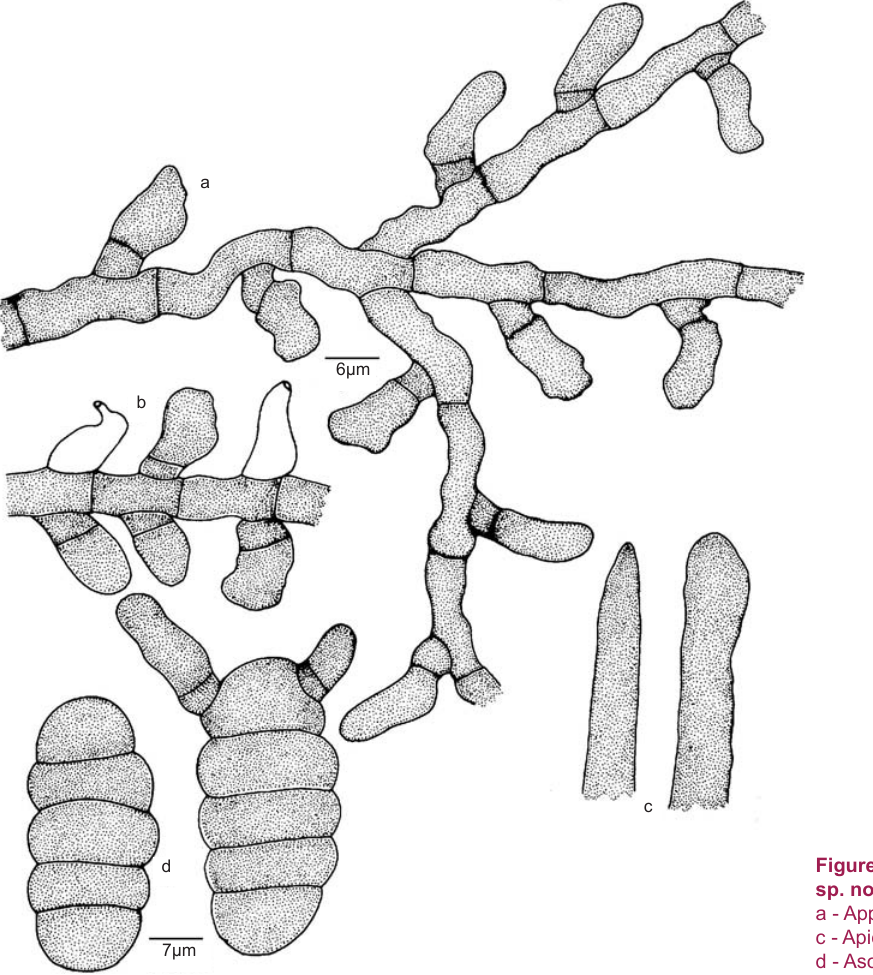
Figure 3. Meliola strombosiigena sp. nov. a - Appressorium; b - Phialide; c - Apical portion of the mycelial setae; d -